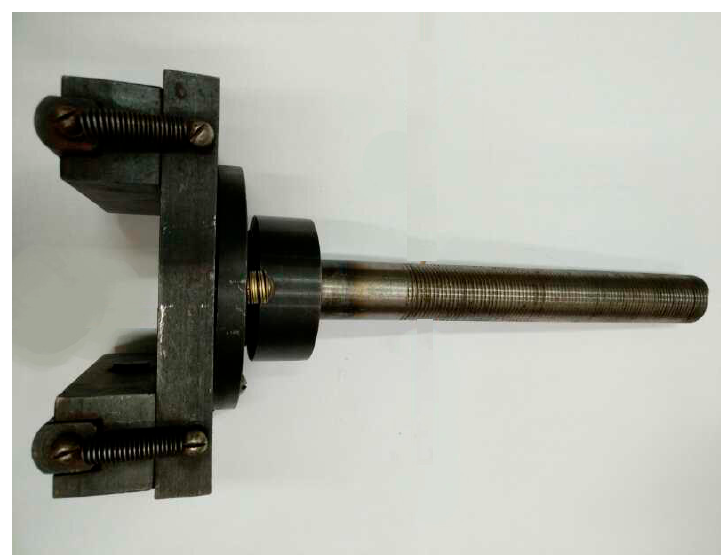
Figure 4. Specimen clamp for tests.